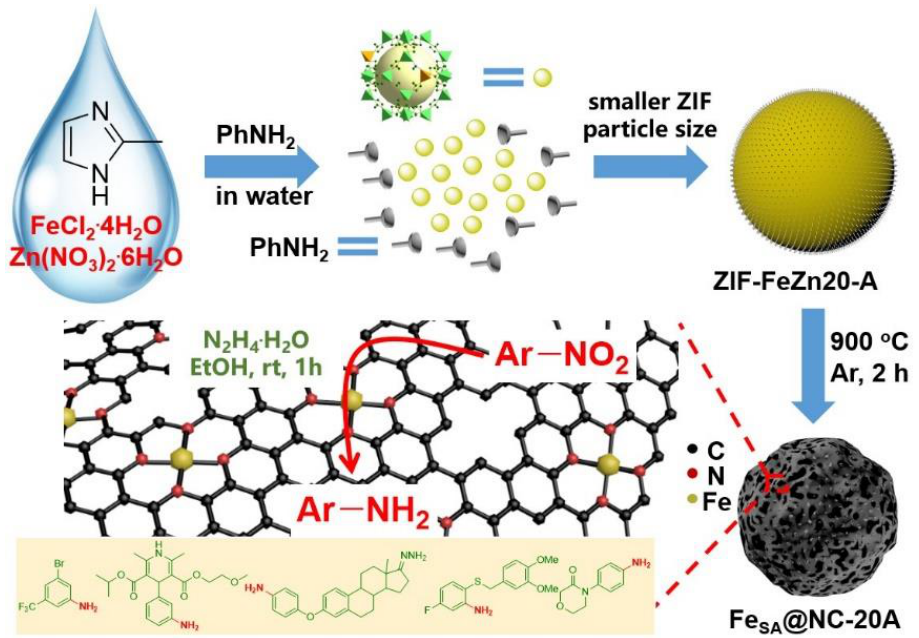
Figure 12. The preparation process of Fe SA @NC-20A. Reprinted with permission from Ref. [84]. Copyright 2022, Springer Nature.